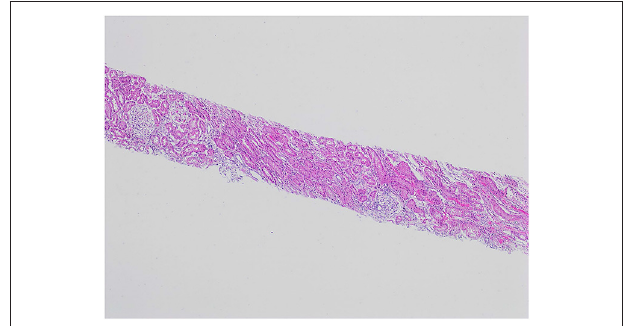
FIGURE 1 | H&E, 4X: The renal biopsy shows glomeruli with normal cellularity and no significant tubular atrophy or interstitial fibrosis.